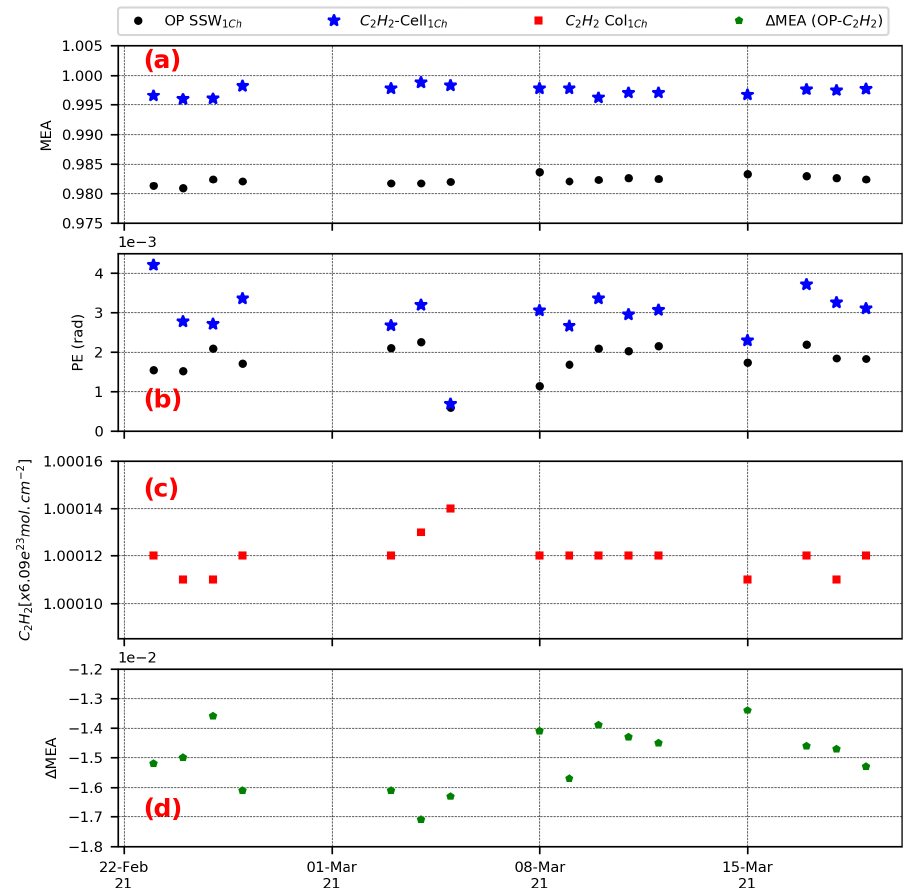
Figure 15. Time series of the MEAs, PEs, C 2 H 2 retrieved column and difference between the MEAs retrieved with OP and cell method for the COCCON reference instrument SN37 ( a , b , c and d , respectively).